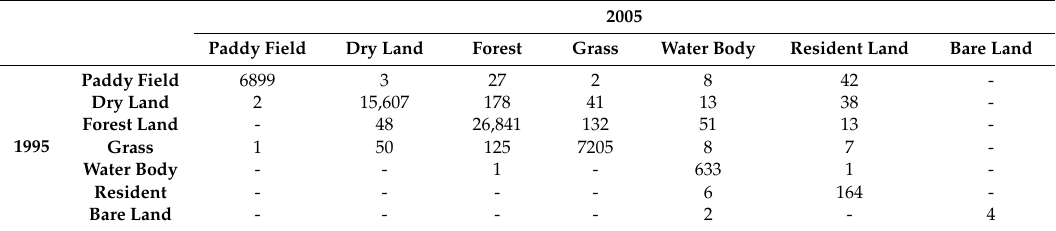
Table 3. Land use transition matrix in the study area from 1995 to 2005 (unit: km 2